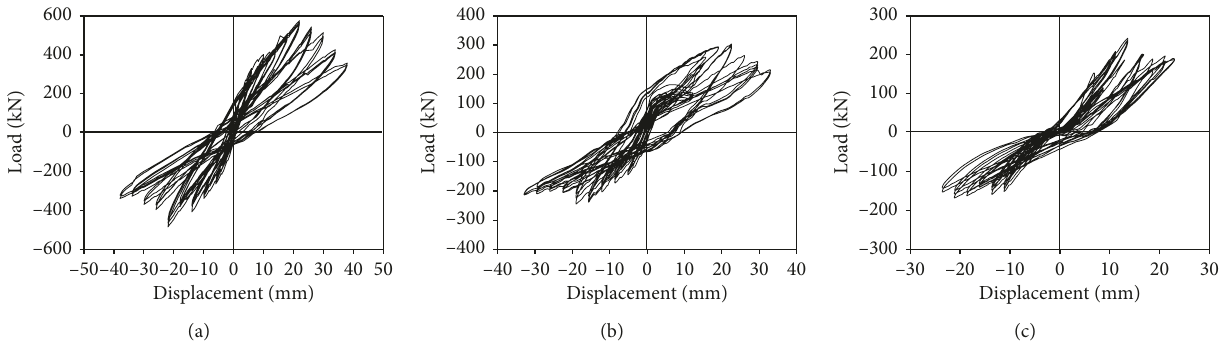
Figure 10: Load-displacement hysteresis curves under low reversed cyclic loading. (a) First layer. (b) Second layer. (c) Third layer. Table 3: Interlayer drift and energy dissipation of the prestressed fabricated concrete frame. Load